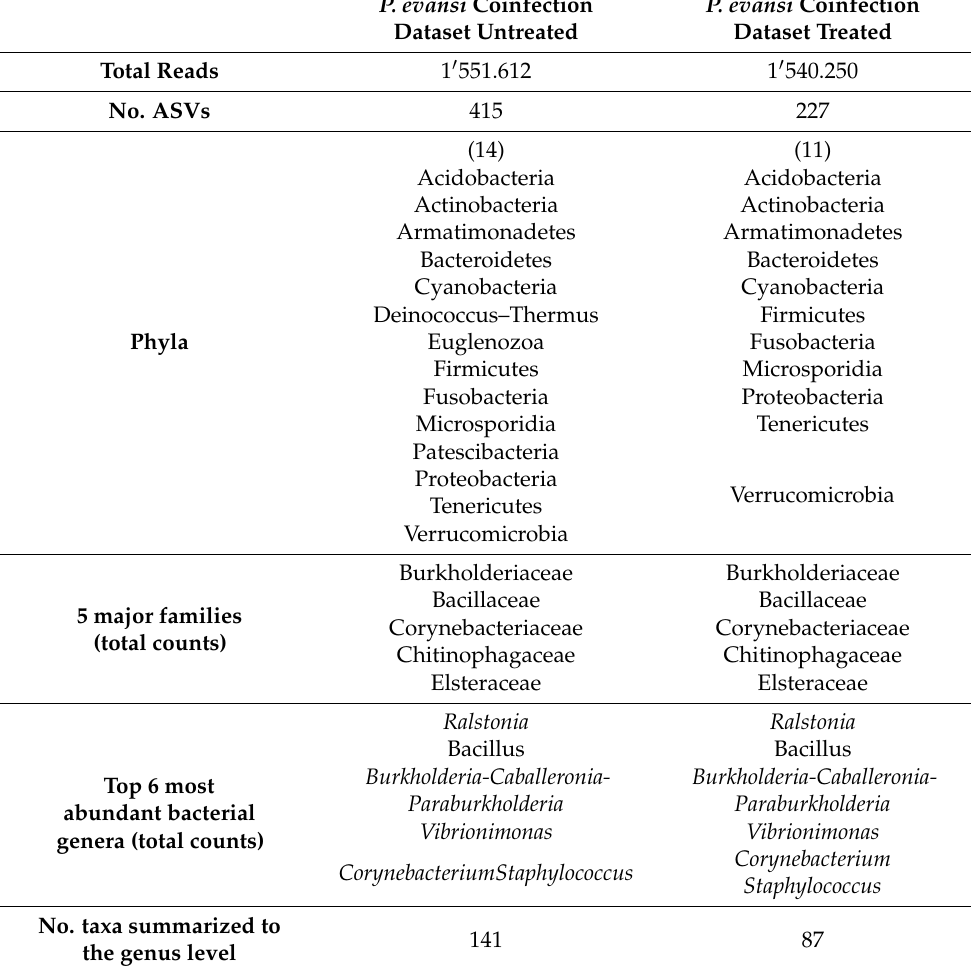
Table 2. Summary of the results obtained from 16S rRNA gene amplicon sequencing of P. evansi gut microbiota under experimental infection with L. infantum and treated with